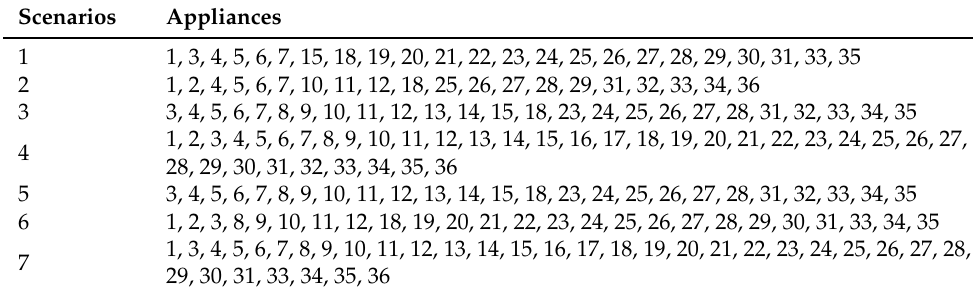
Table 2. Main characteristics of the seven scenarios.